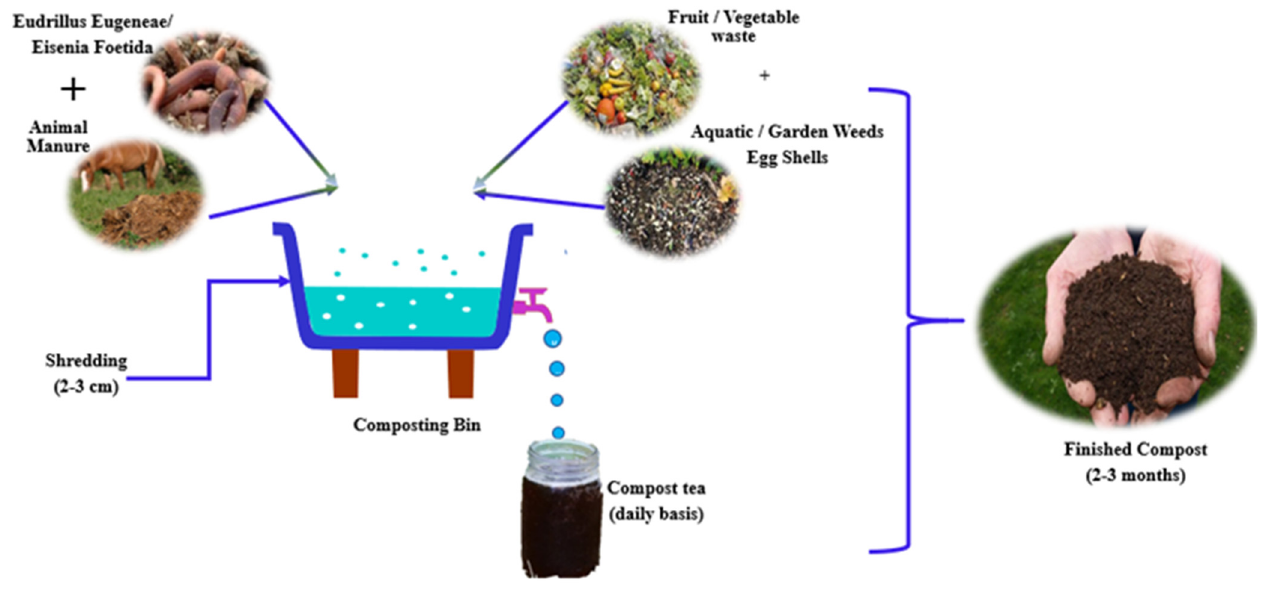
Figure 3. Schematic of vermicomposting production process. Table 3. Discrete composting parameters utilized in the vermicomposting process.